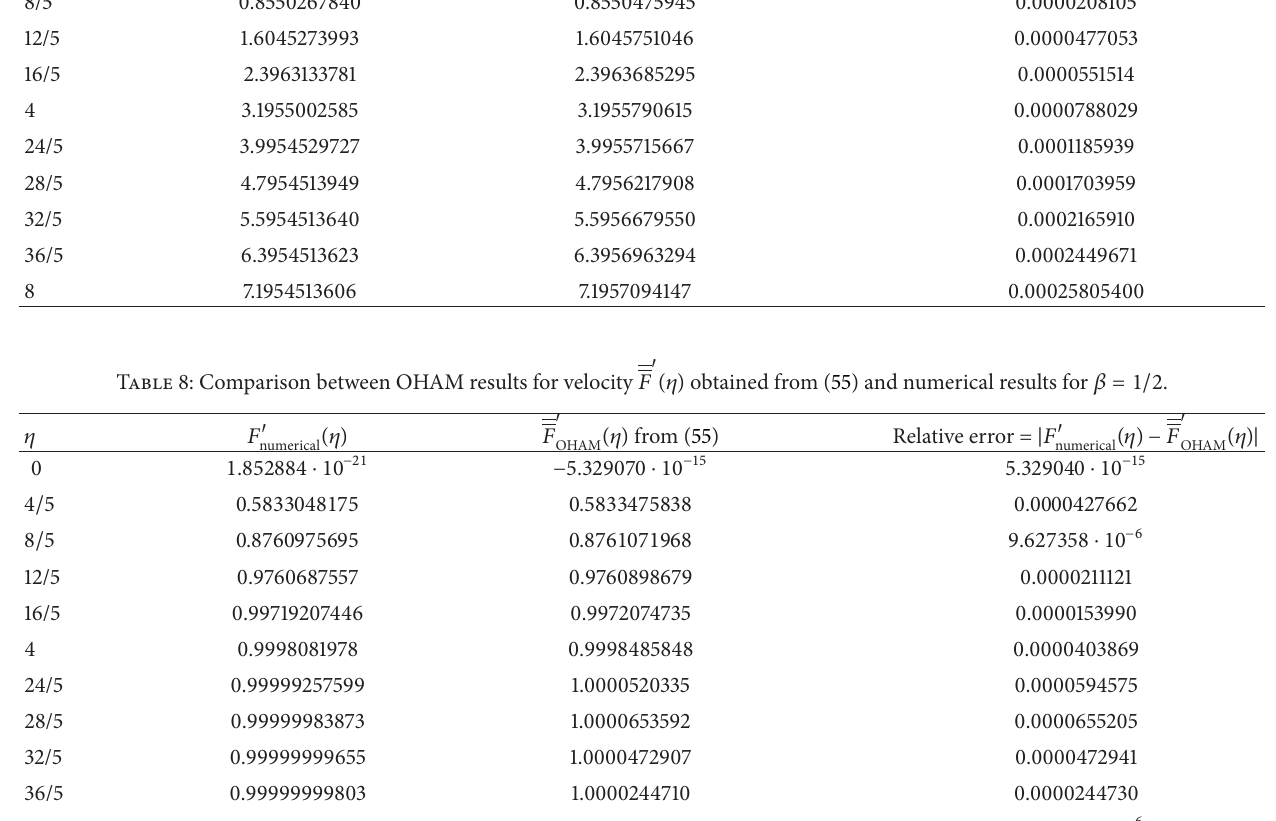
Table 7: Comparison between OHAM results given by (55) and numerical solutions for 𝛽 = 1/2 . 𝜂